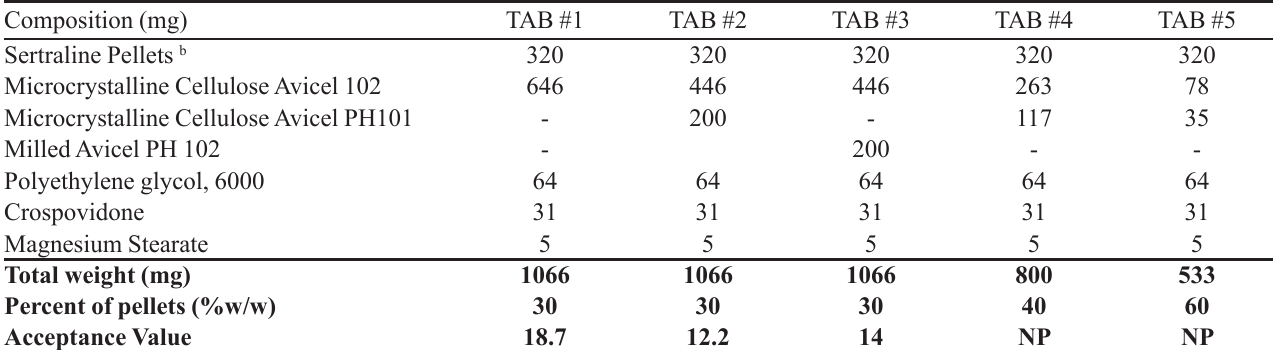
TABLE II - Composition of MUPS tablets prepared using calcium chloride-treated pellets Composition